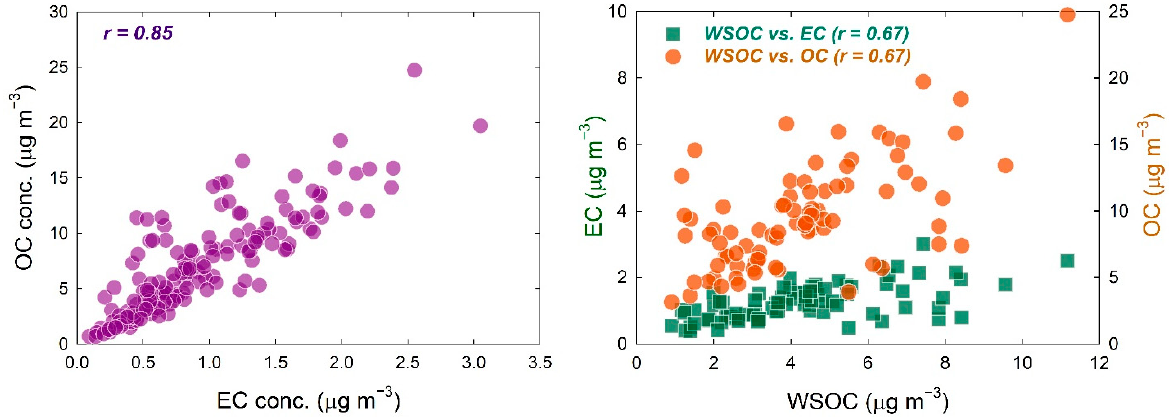
Figure 3. Correlations between EC and OC ( left ) and between WSOC and EC (green squares) and between WSOC and OC (orange circles).